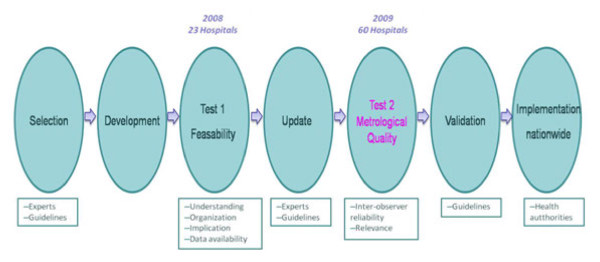
Steps in the development of QIs for breast cancer care by COMPAQ-HPST.